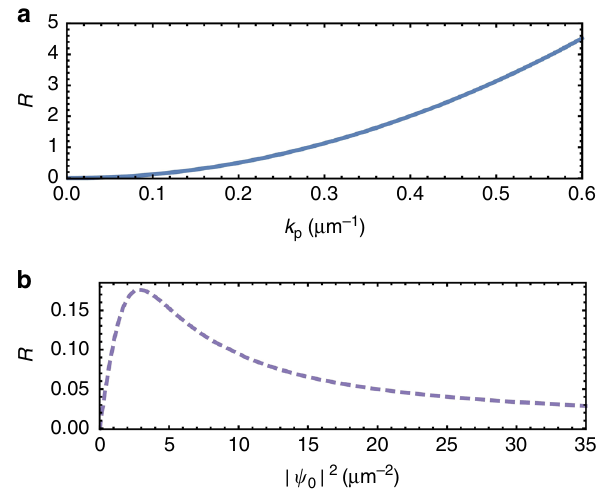
Fig. 4 Response at zero detuning. The long wavelength response, normalised to the mean- fi eld density, R = m * χ xx ( q → 0 )/| ψ 0 | 2 , as a function a of pump momentum k p at | ψ 0 | 2 = 6.9 µ m − 2 , and b the mean- fi eld density | ψ 0 | 2 at k p = 0.1 µ m − 1 . The detuning is zero in both cases